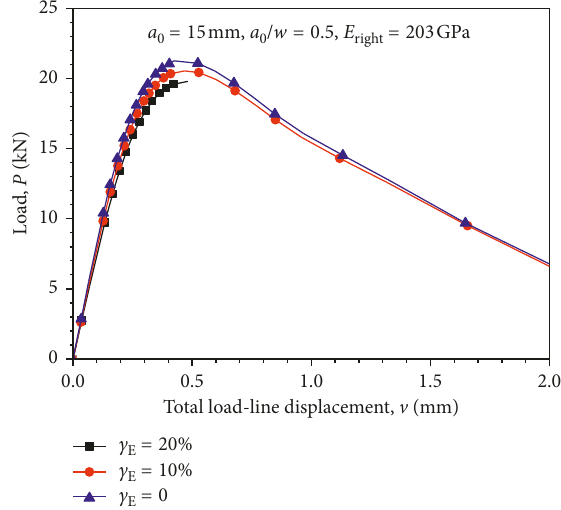
Figure 9: Load-applied displacement curve of elastic modulus mismatch specimen.